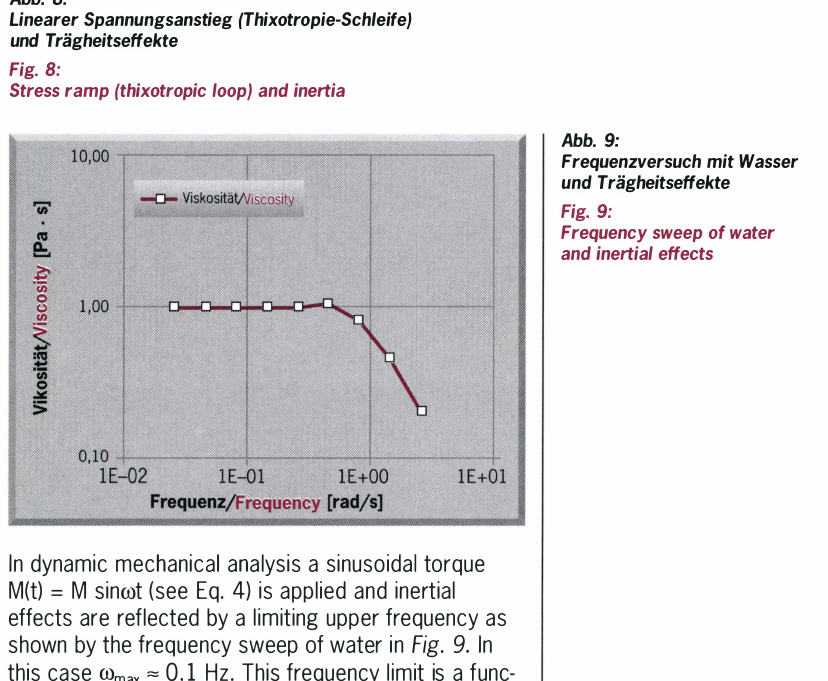
Fig. 8: Stress ramp (thixotropic loop) and